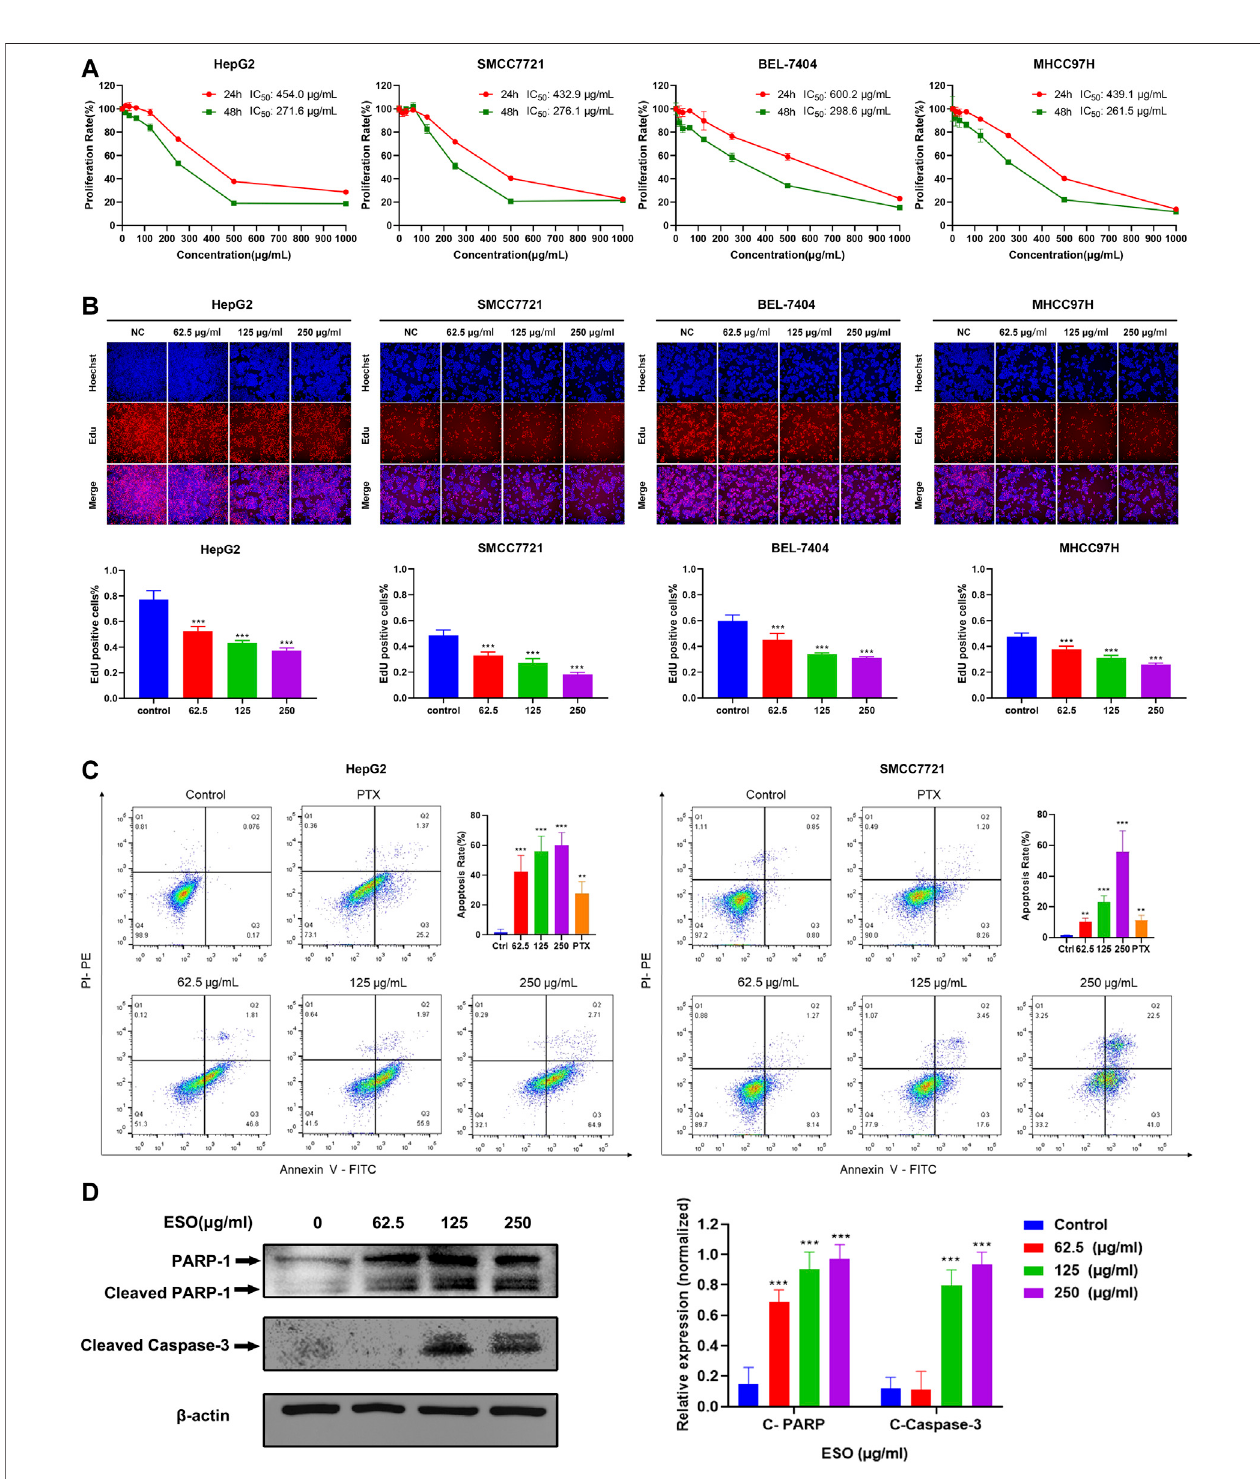
FIGURE7| SOinhibits HCC cellproliferationand induces cellular apoptosis. (A) thecell viabilitywastested byCCK8 assay, showing atime-and dose-dependent inhibitingeffect ofESO treatmenton the viabilityofHCC cells. n (cid:2) 3. (B) EdU assays wereperformedto verify theeffects ofESO treatment on HCC cellsproliferation, the rateofEdU-posivecellswascalculated. n (cid:2) 3. (C) ApoptosisanalysisofESO-treatedHepg2andSMCC7721cellswasanalyzedby fl owcytometryafterAnnexinV-FITC/ PI staining. n (cid:2) 3. The concentration of PTX of positive control group was 40 nM, (D) The protein levels of PARA and cleaved Capase-3 in HepG2 cell. β -actin was used as an internal control. * p < 0.05, ** p < 0.01, *** p < 0.001 vs. the nontreated control group.